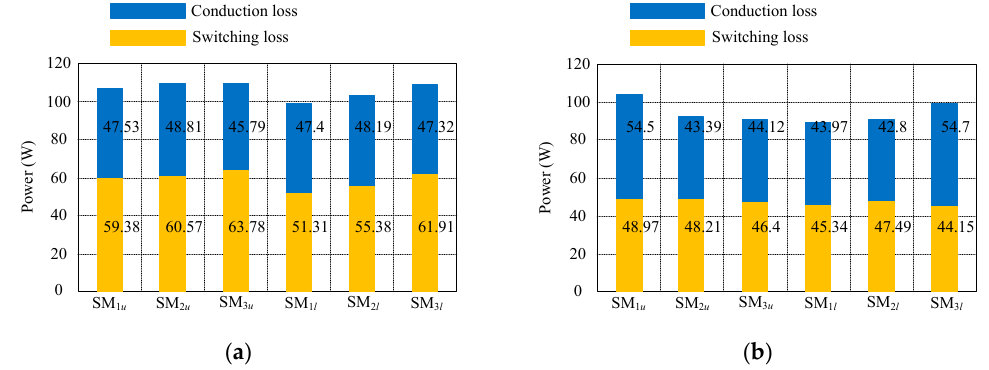
Figure 9. Switching losses and conduction losses among SMs of MMC: ( a ) without switching loss balancing control; ( b ) with switching loss balancing control.